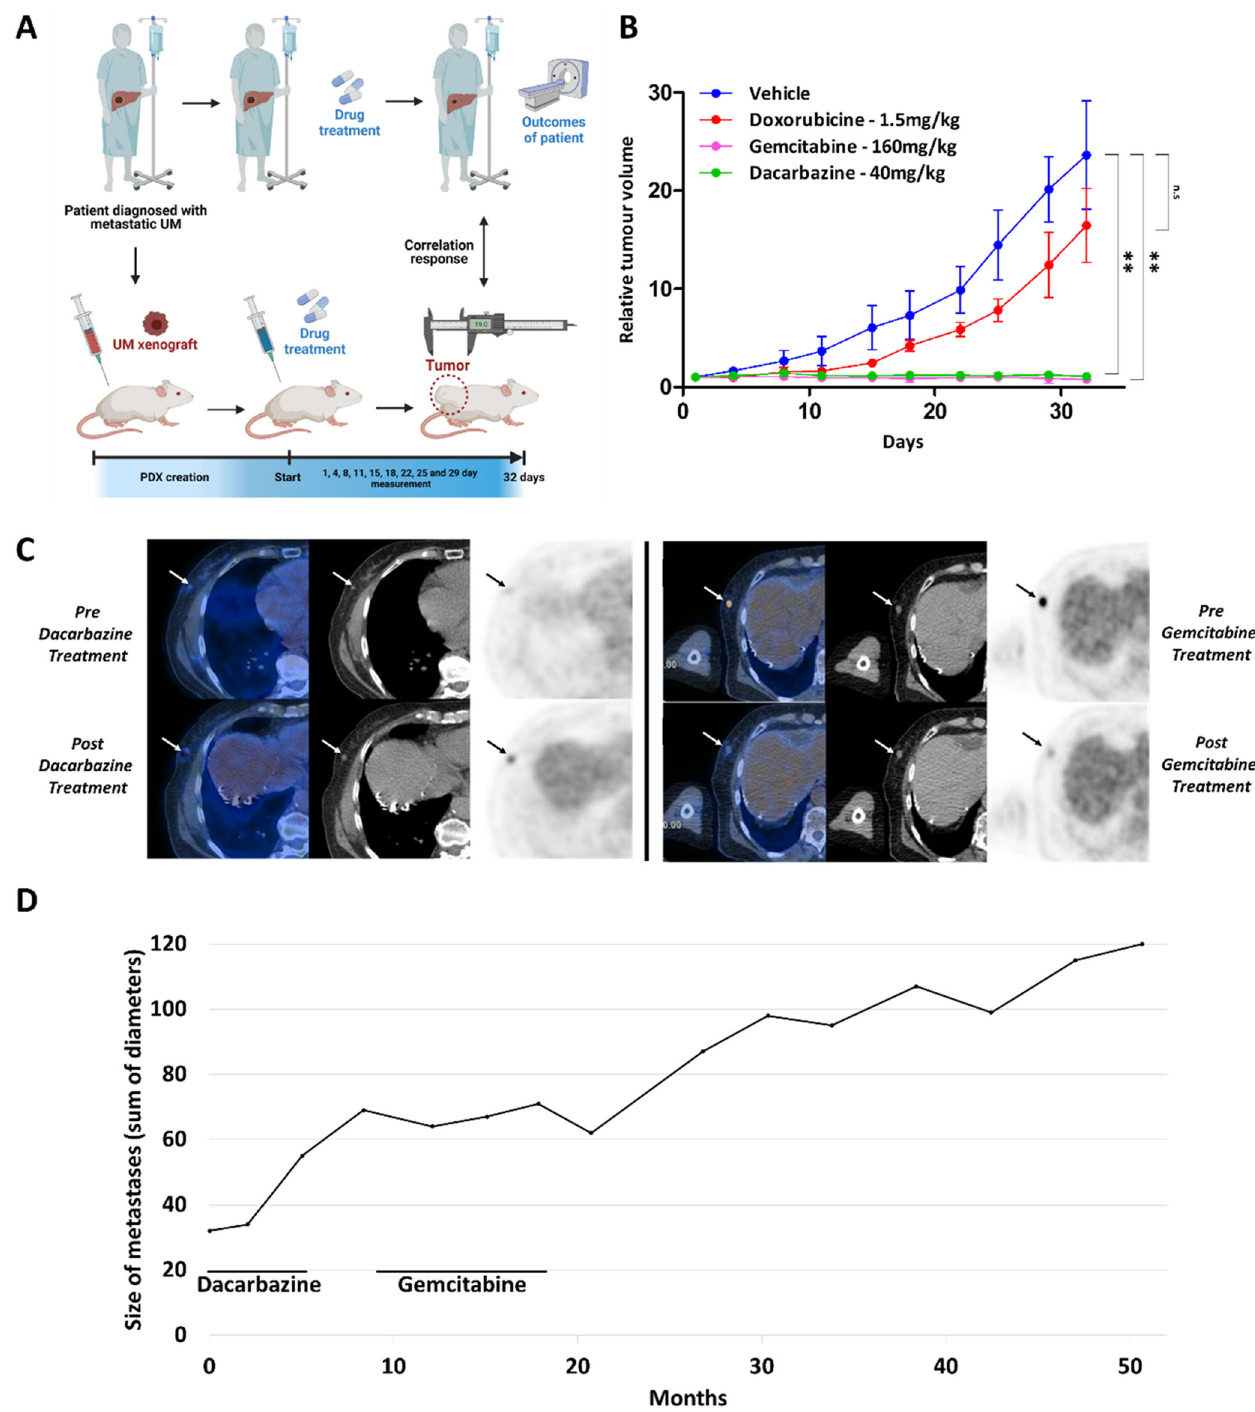
Fig. 4 Activity of gemcitabine in an MBD4-de fi cient UM patient-derived xenograft (PDX) model and in the corresponding metastatic patient. A Schema of a co-clinical trial model between a PDX model and the patient from whom was derived the PDX. Created with BioRender.com. B Mice were treated with different drugs and tumor growth was assessed by measuring the relative tumor volume (RTV) for 32 days ( n = 4 mice/drug, mean ± SD; n.s non-signi fi cant; ** P < 0.01; unpaired two-sided Student ’ s t -test). C Positron emission tomography- computed tomography images before and after 5 months of dacarbazine (upper panel), and before and after 9 months of gemcitabine treatment (lower panel). Arrows show locations of metastatic lesions. D Evolution of the size of metastases during and after dacarbazine or gemcitabine